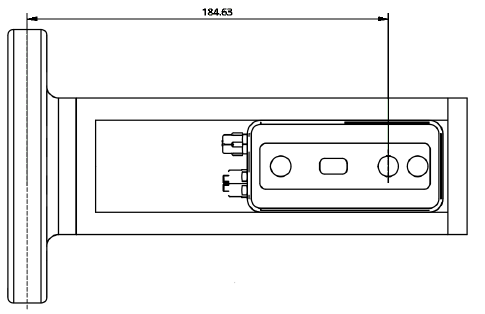
Figure 12. Camera holder CAD model with dimensions in TCP’s z -axis.